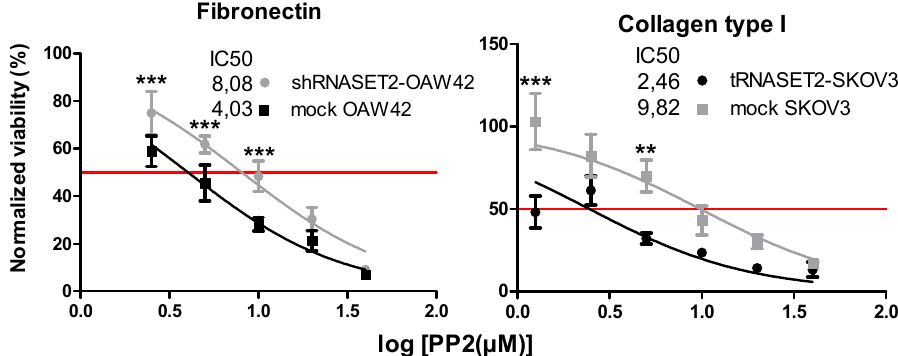
Figure 6. EOC cells with the ‘RNASET2 phenotype’ are sensitive to src inhibitor. Cell viability assay of mock/shRNASET2-OAW42 (left panel) and mock/tRNASET2-SKOV3 cells (right panel) treated with PP2 (0, 2.5, 5, 10, 20, and 40 μ M) up to 72 h. Asterisk indicates significant values (*** p < 0.001 and ** p < 0.01). Error bars, SD.